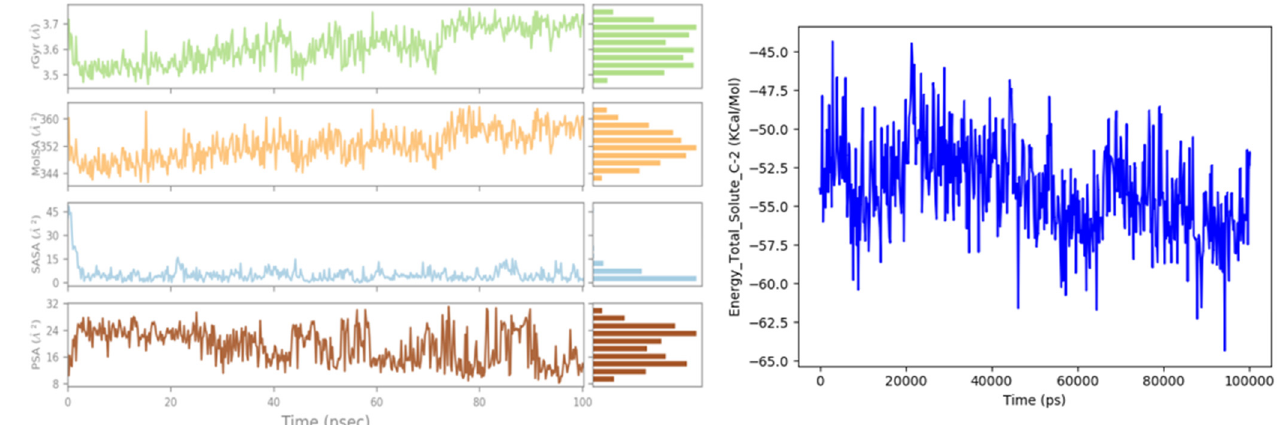
Figure 12. Rg, MolSA, SASA and PSA during 100 ns of MD simulation, and the variation of total free energy for the ligand 9 complexed with DAT protein.